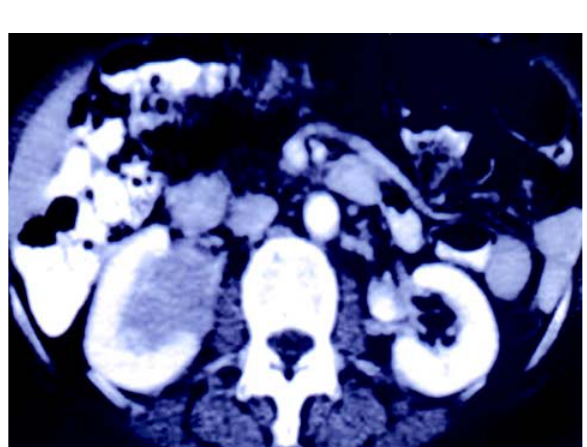
Figure 1 – A four-centimeter solid and intra-sinusal right renal mass with contrast enhancement.